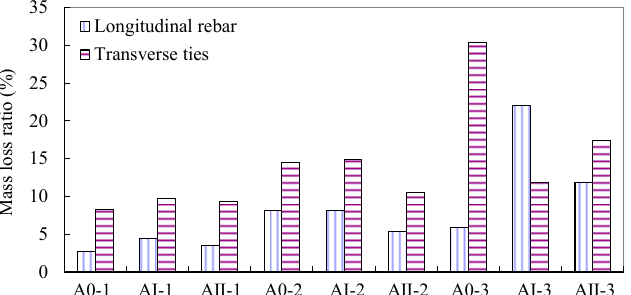
Figure 5. Corrosion degree of reinforcement obtained from mass loss measurements.